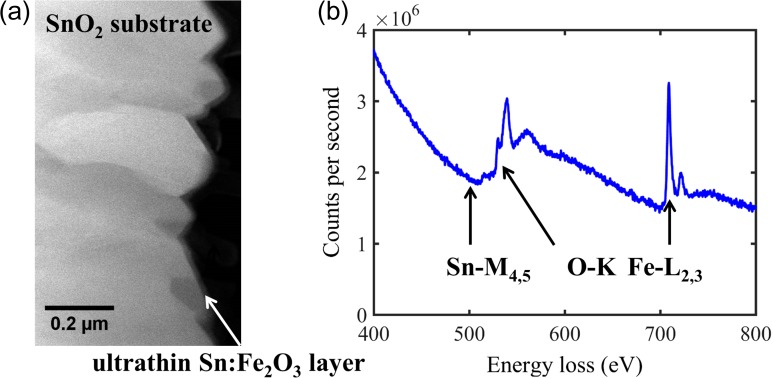
(a) HAADF-STEM micrograph of an ultrathin Sn:Fe2O3 photoanode on the fluorine doped SnO2 substrate. (b) The sum core loss spectrum of an EELS spectrum imaging.